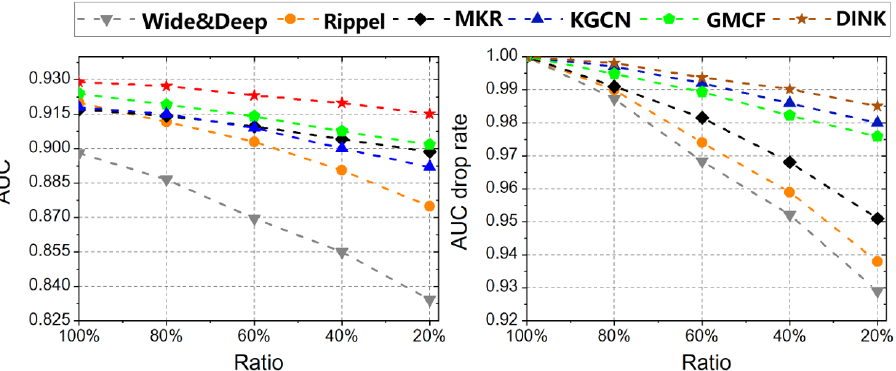
Figure 3. Performance of each model in the cold start scenario.